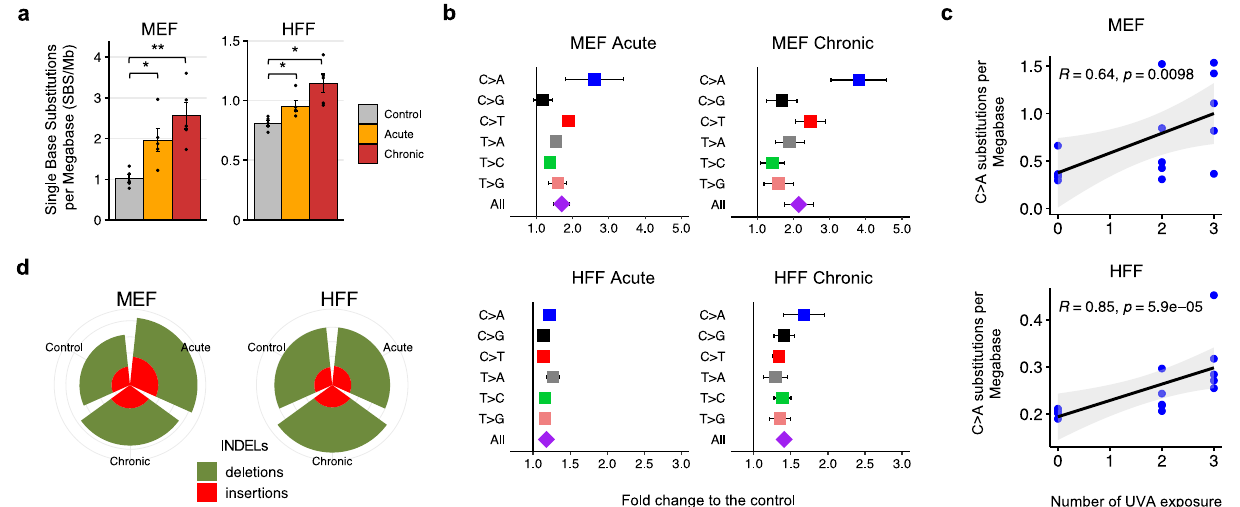
Fig. 5 | Mutations found in the genomes of MEFs and HFFs irradiated by a UV- nail dryer. a Mutation count per megabase (Mb) detected in the different condi- tions, represented incolors, in MEFs and HFFs.Datais presentedasameanvalue± standarderrorfrom n =5independentbiologicalreplicates.Statisticallysigni fi cant results from FDR corrected Mann – Whitney U two-sided tests are denoted as: * q - value<0.05; ** q -value < 0.01. b Fold increase of single base substitutions in UV- treated clones compared to controls. Fold increase is expressed as mean fold- change ± SE (standard error)from n =5 independent replicates. c Spearman ’ s rank